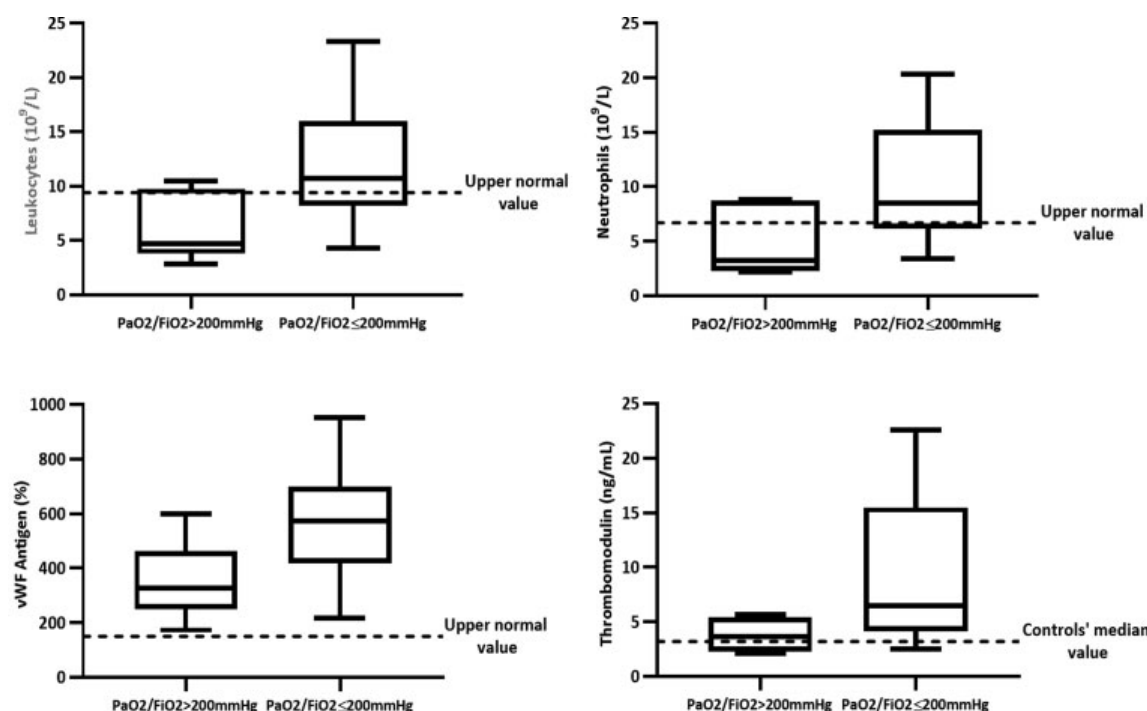
Fig. 2 In fl ammatory and endothelial biomarkers in relation to low (PaO2/FiO2 > 200mmHg) and moderate-severe ARDS (PaO2/FiO2 (cid:1) 200mmHg).